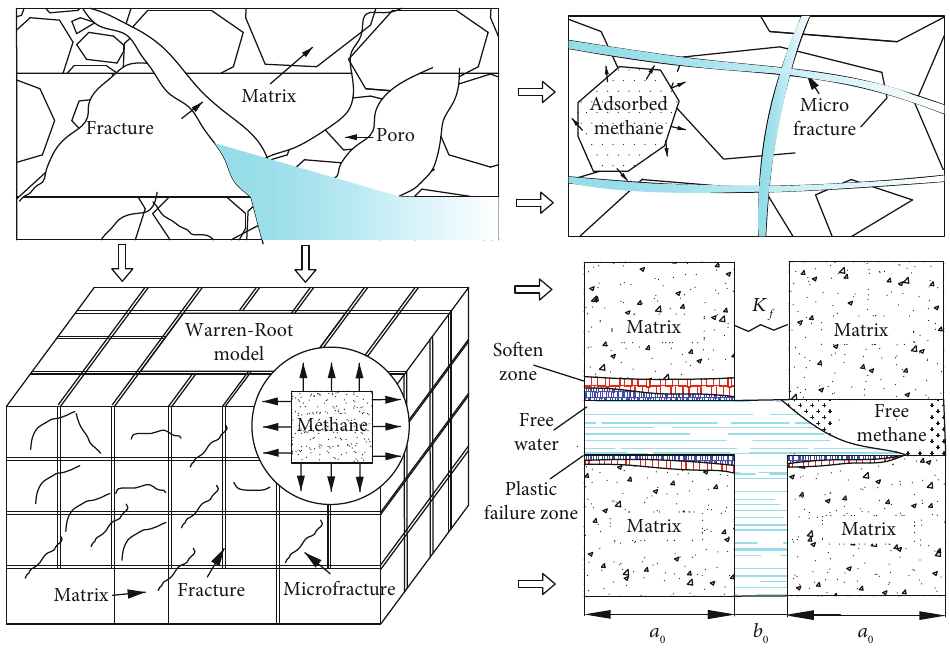
Figure 3: Concept diagram of a coal seam and fl uid fl